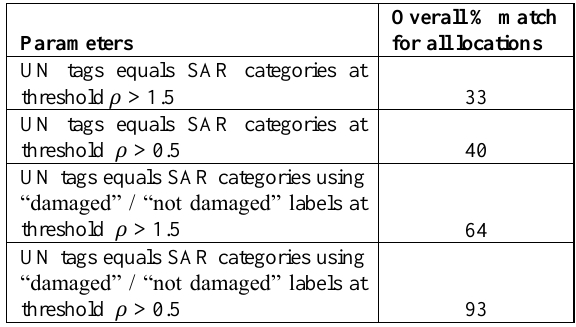
Table 5. Overall percentage matches between UNITAR / UNOSAT damage tags and SAR-derived rapid